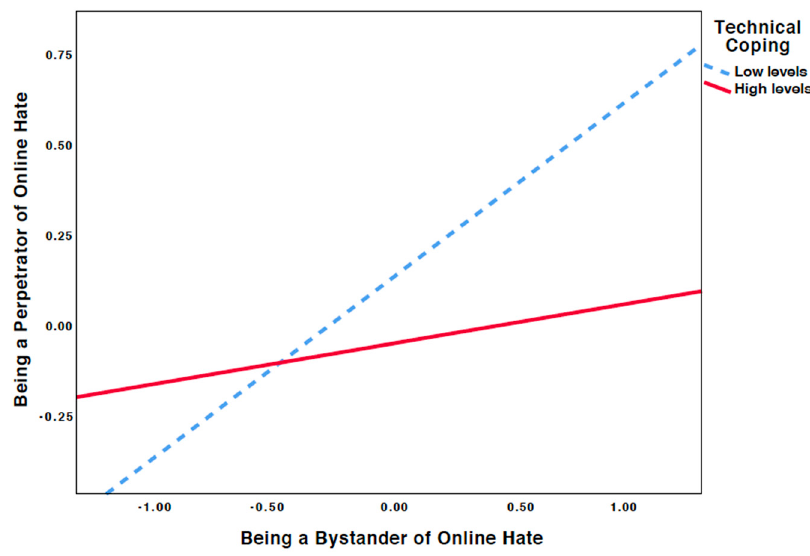
Figure 2. Simple slope equations of the regression of online hate bystanders on online hate perpetrators at high and low levels of technical coping.